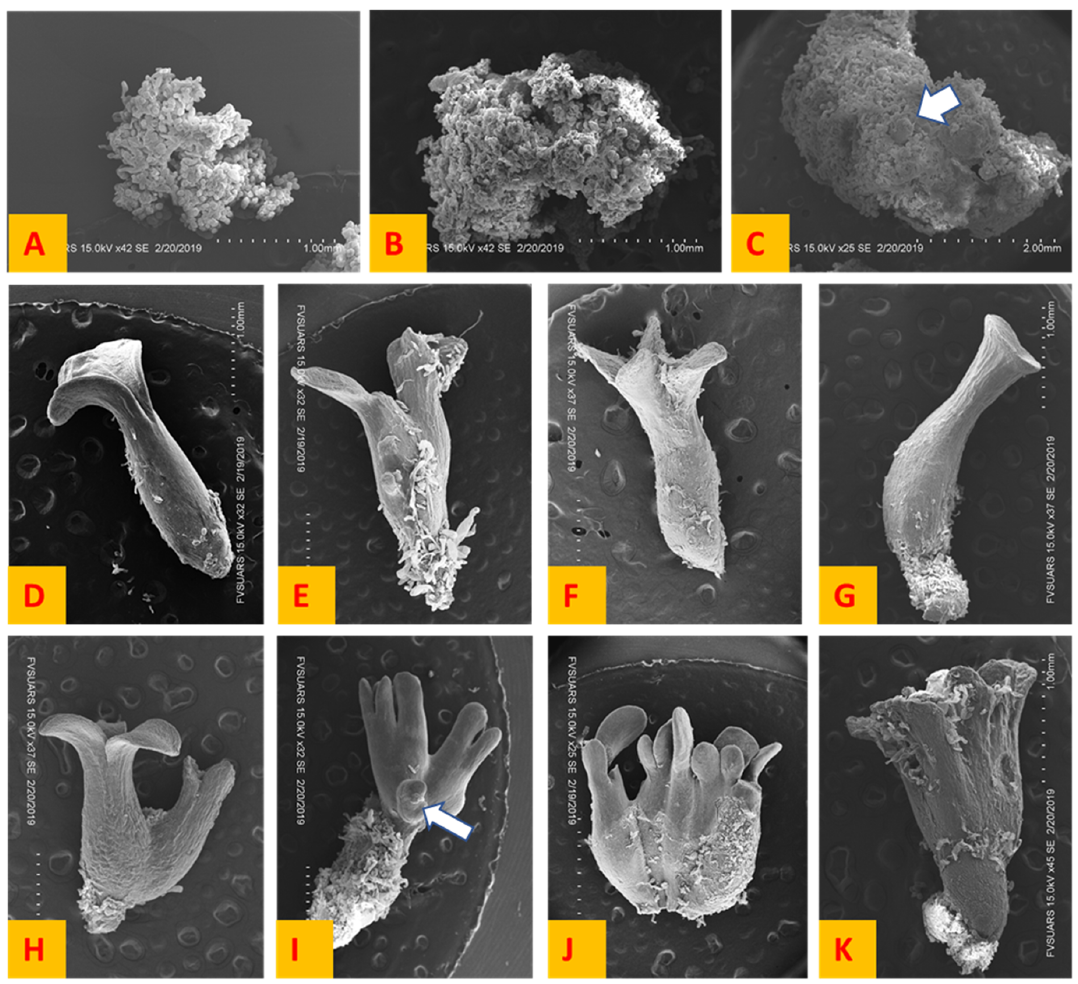
Figure 10. Scanning electron micrographs. ( A ) Loosely arranged disorganized cells in the callus, ( B ) cells getting compactly arranged to form globular embryos, ( C ) formation of globular embryos (indicated by an arrow) among the compactly arranged callus cells, ( D ) monocotyledonous, ( E ) dicotyledonous, ( F ) polycotyledonous, ( G ) long hypocotyl, vestigial cotyledon, ( H ) proximal di-axial fusion, ( I ) di-axial fusion with emergence of a secondary embryo (indicated by an arrow) at the base, ( J ) moderately fasciated and ( K ) gross fasciation.